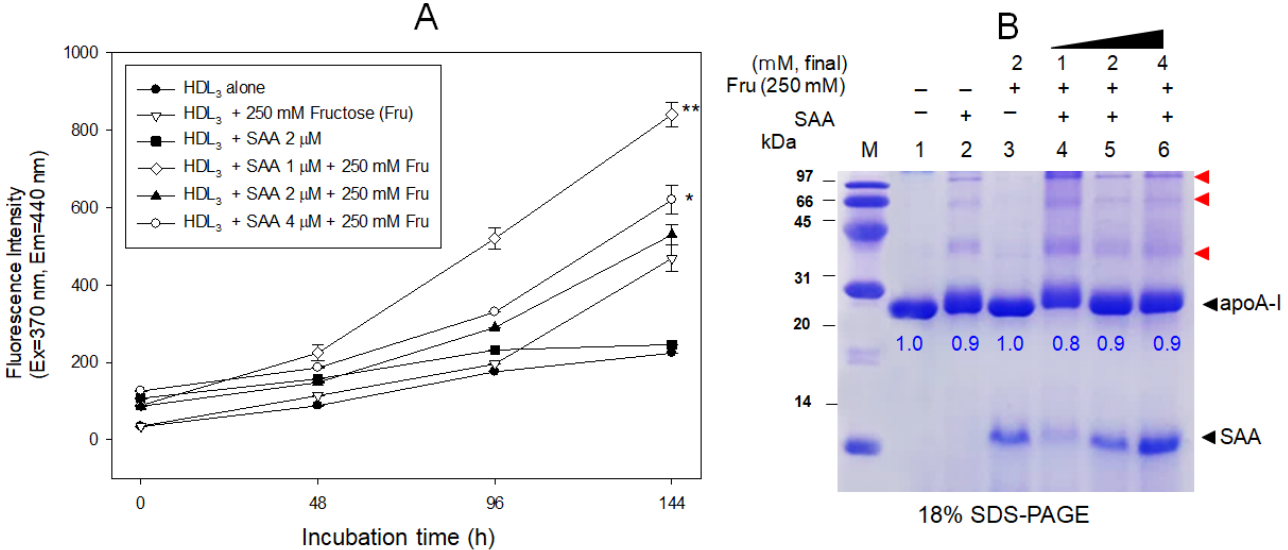
Figure 7. Increase in the extent of glycation in HDL 3 by co-treatment of serum amyloid A and fructose (Fru, final 250 mM). ( A ) Fluorospectroscopic determination of the advanced glycated end product (Ex = 370 nm, Em = 440 nm) in the HDL 3 . *, p < 0.05 versus HDL 3 + Fru; **, p < 0.01 versus HDL 3 + Fru. ( B ) Electrophoretic patterns of glycated HDL 3 with visualization of Coomassie Blue staining (18% SDS-PAGE). The red arrow indicates a multimerized band of apoA-I due to glycation. Lane 1, HDL 3 alone; lane 2, HDL 3 + Fru; lane 3, HDL 3 + SAA (2 μM); lane 4, HDL 3 + SAA (1 μM) + Fru; lane 5, HDL 3 + SAA (2 μM) + Fru; lane 6, HDL 3 + SAA (4 μM) + Fru. The blue numbers in the photograph indicate the band intensities (BI) of each apoA-I band. The BI was compared by band scanning with Chemi-Doc ® XR (Bio-Rad, Hercules, CA, USA) using Quantity One software (version 4.5.2) from three independent SDS-PAGE.